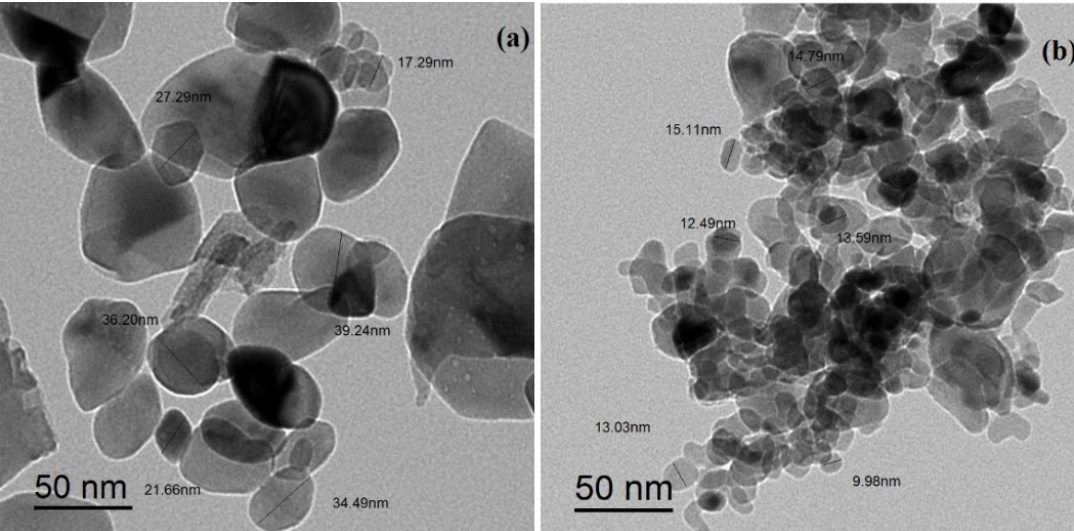
Figure 2. Scanning electron microscope (SEM) images for ( a ) T CuO NPs and ( b ) G CuO NPs.